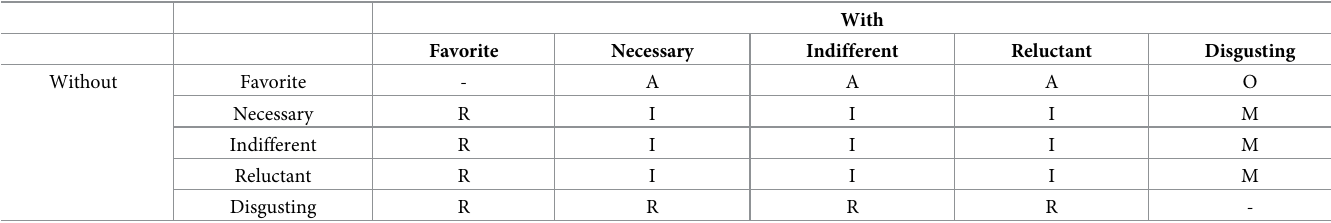
Table 2. Demand classification judgment